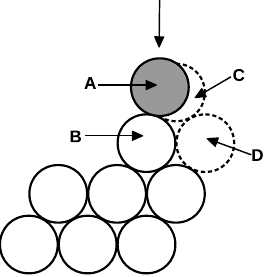
Figure 9. Surface relaxation for physisorbed radicals. ( A ) Incident particle location; ( B ) Surface Si particle in lattice; ( C ) Predefined triangular lattice site with one nearest neighbor; ( D ) Stable position for incident particle (two nearest